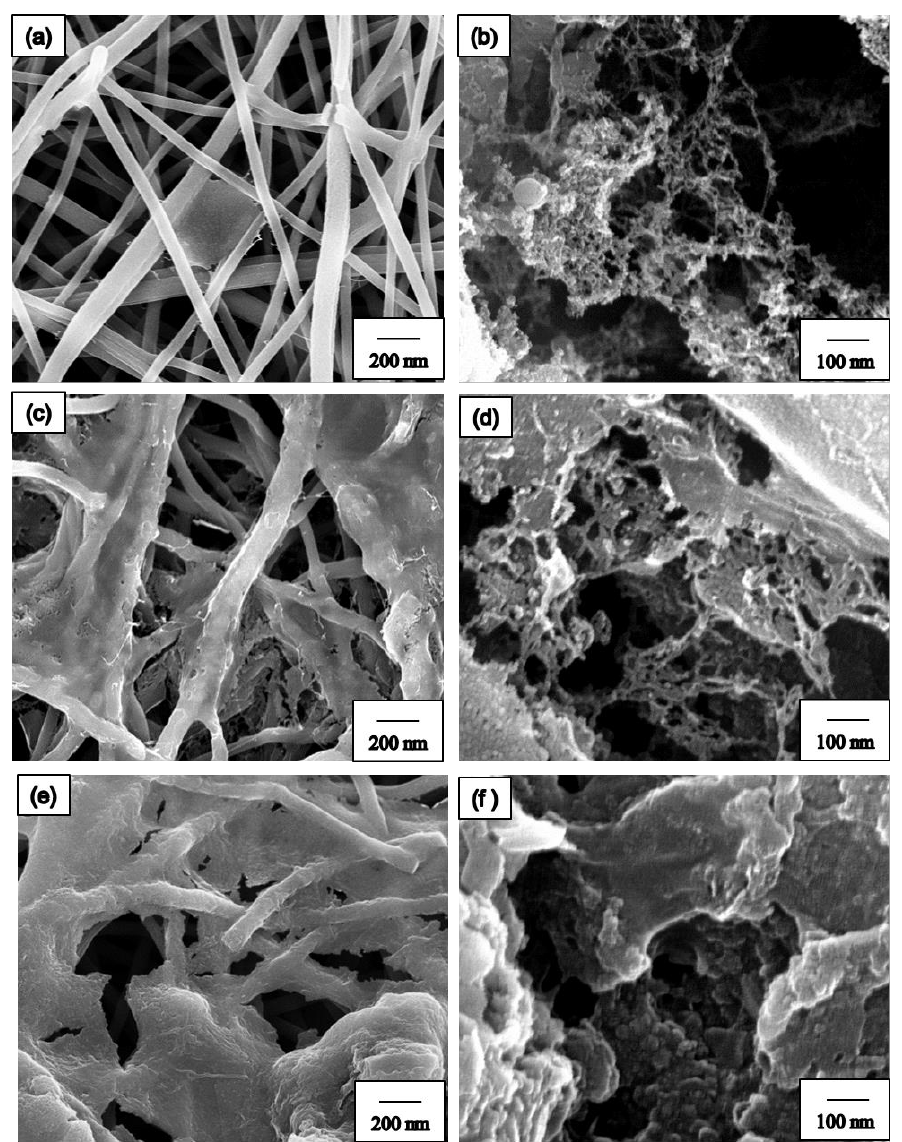
Figure 5. FE-SEM images of BN structure synthesized with di ff erent precursor ratio of B 2 O 3 and CH 4 N 2 O with di ff erent molar ratio. 1:10 ( a ) low magnification, ( b ) high magnification; 1:5 ( c ) low magnification, ( d ) high magnification; 1:1 ( e ) low magnification, ( f ) high magnification.